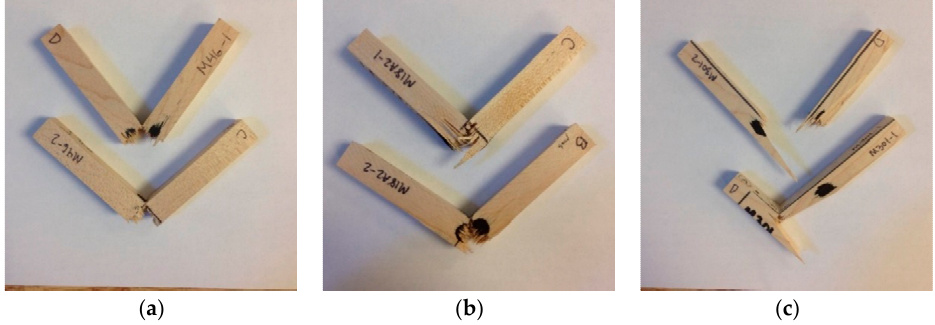
Figure 8. Charpy samples of varying SoG ( a ) |SoG| < 1°, ( b ) 1° < |SoG| < 3° and ( c ) |SoG| > 3°.